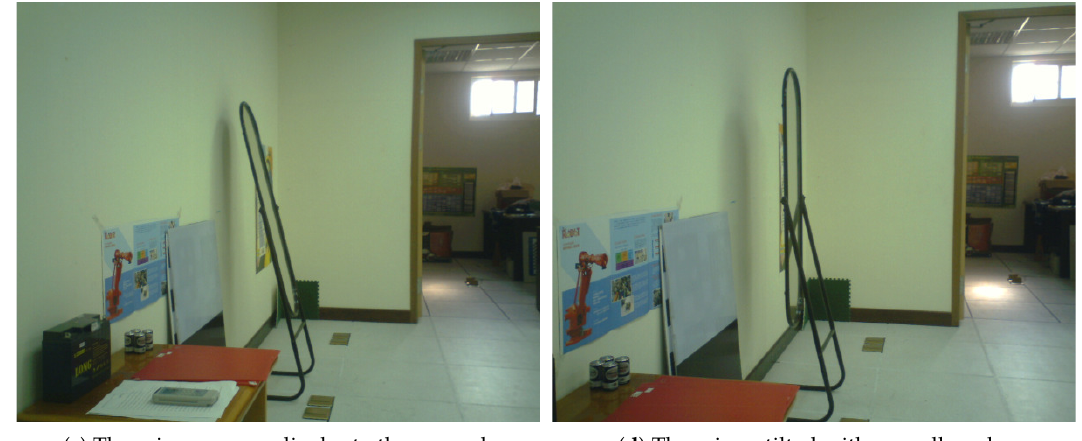
Figure 7. The detection of vertical 3D lines in the space. The red lines in Figure 7a,b indicate the detected vertical 3D lines. The images in which a mirror is placed perpendicular to the ground and tilted with a small angle are shown in Figure 7c,d.